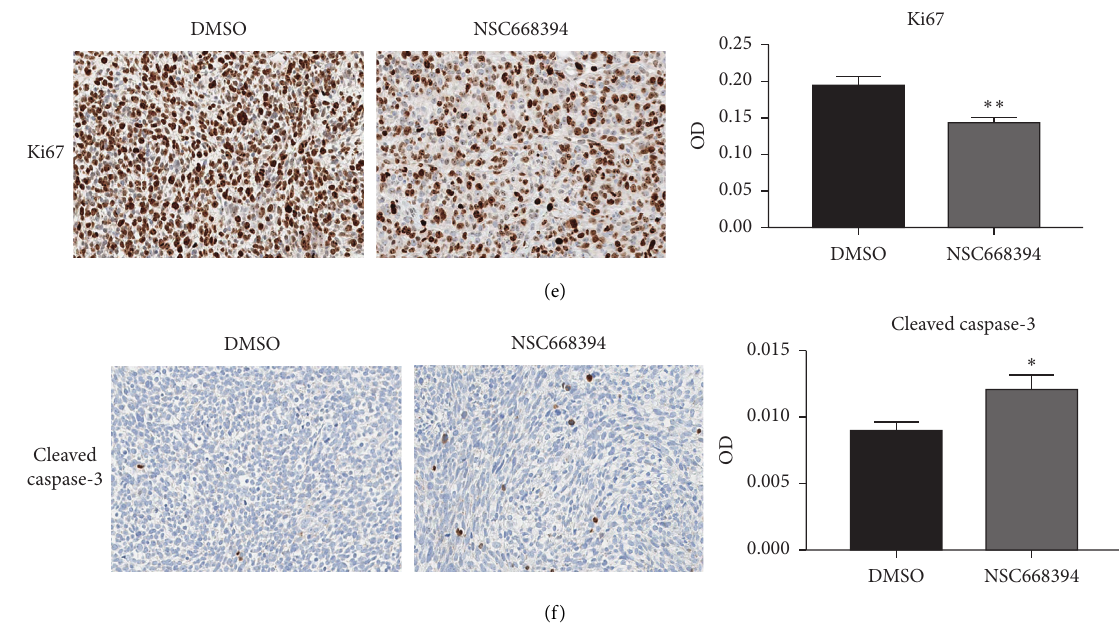
Figure 4: NSC668394 inhibits the growth of RD xenograft in vivo. (a) Subcutaneous (SQ) RD tumor volumes in NSG mice subjected to daily intraperitoneal administration of either 20mg/kg NSC668394 ( n � 6) or DMSO ( n � 6). (b) Orthotopic intramuscular (IM) RD tumor volumes in NSG mice subjected to daily intraperitoneal administration of 40mg/kg NSC668394 ( n � 10) or DMSO ( n � 10). Total body weight of NSG mice bearing subcutaneous (c) and orthotopic (d) RD tumors on the indicated days. Negative values shown on the x -axis of total body weight plots represent days prior to starting NSC668384 treatment. Individual data points are represented as mean ± SEM. Asterisks represent a significant difference between treatment groups ( ∗ p < 0 . 05, ∗∗ p < 0 . 005, ∗∗∗ p < 0 . 0005, and p < 0 . 0001 � ∗∗∗∗ ) for the given time point as determined by RM two-way ANOVA with Holm-ˇS´ıd´ak multiple comparisons tests. Representative images of sub- cutaneous xenograft sections stained for Ki67 (e) or cleaved caspase-3 (f). Each stain was quantified as optical density using Fiji extension of ImageJ and plotted as bar graphs. Bars represent mean ± SEM, and asterisks represent a significant difference between treatment groups as determined by the unpaired t -test ( ∗ p < 0 . 05 and ∗∗ p < 0 .